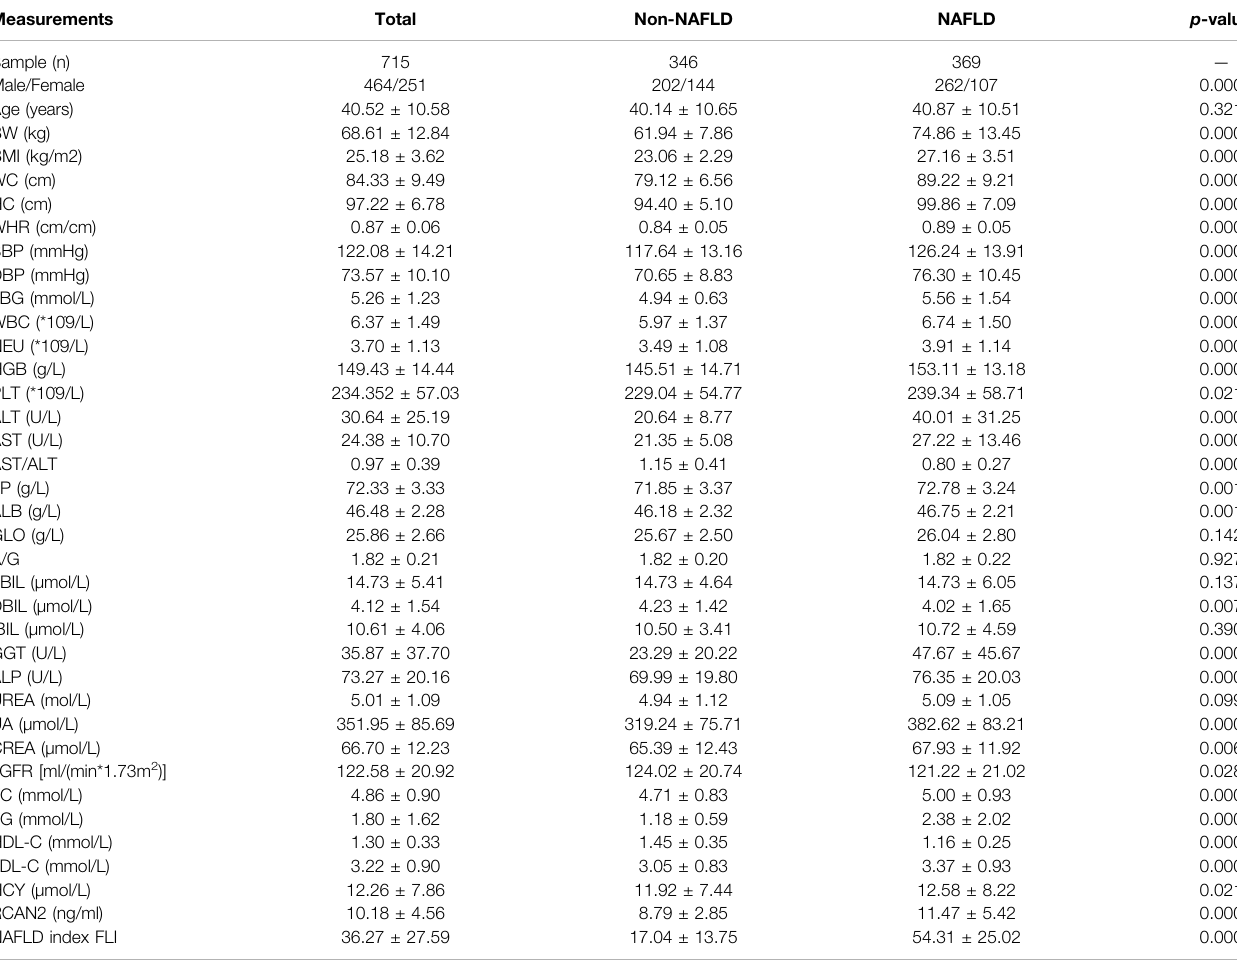
TABLE 1 | Clinical parameters of all participants in the study. Measurements